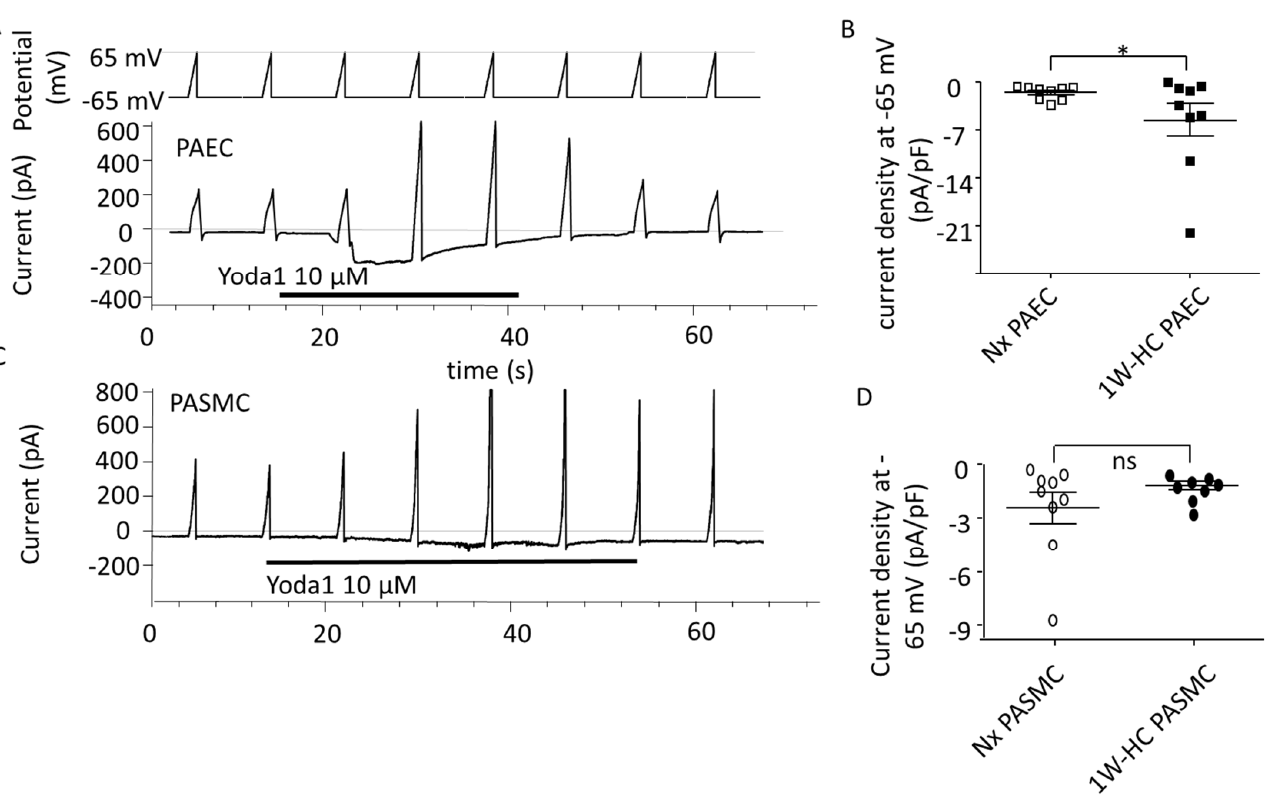
Figure 5. PAEC and PASMC Piezo1 current in an early stage of CH-PH. Yoda1 induced current activation through Piezo1 channels in PAECs and PASMCs. ( A ) Typical current induced by Yoda1 (10 µ M) on PAECs (holding potential − 65 mV, ramp depolarization up to 65 mV). ( B ) Yoda1 induced a greater inward current in 1W-CH PAECs as compared to Nx PAECs at the potential of -65 mV. * p < 0.05. ( C ) Typical current induced by Yoda1 (10 µ M) on PASMCs (holding potential − 65 mV, ramp depolarization up to 65 mV). ( D ) Yoda1 induced the same inward current in 1W-CH PASMCs and Nx PASMCs at the potential of -65 mV. Each point represented a